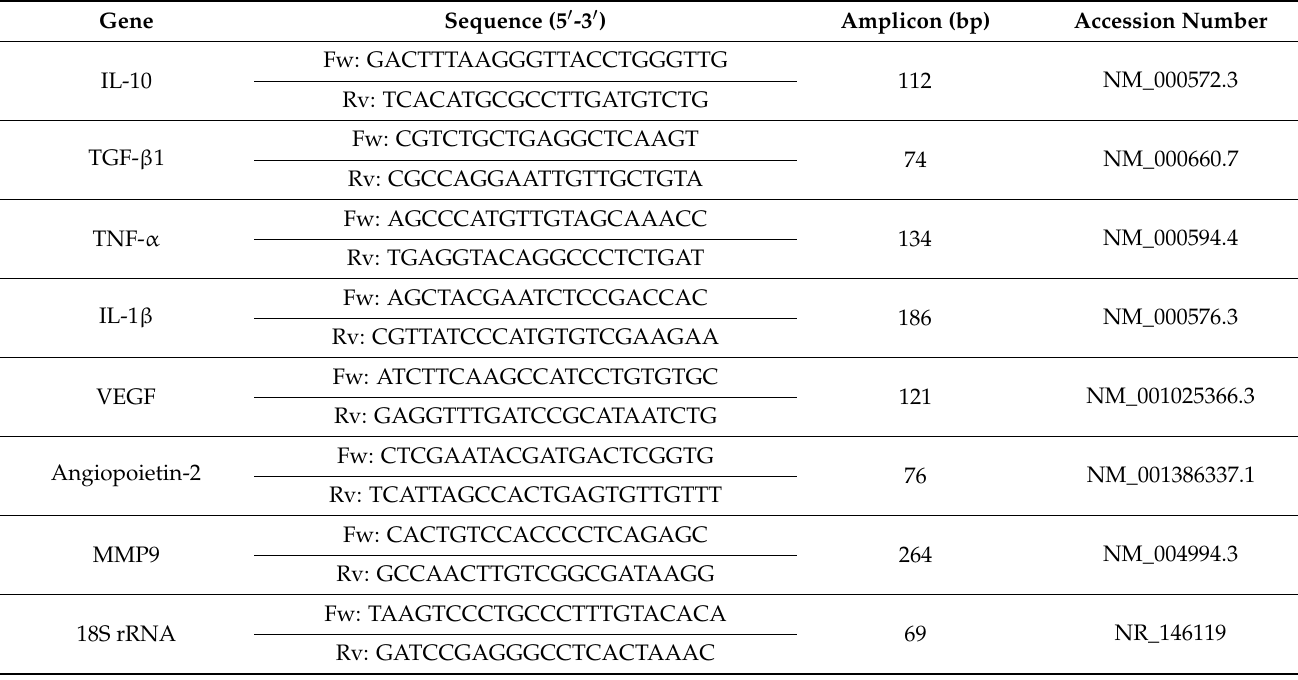
Table 1. Primer sequences used for quantitative